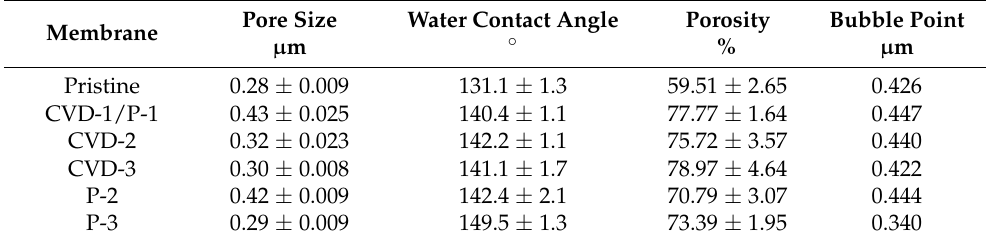
Table 2. The membrane characterization of different CVD and plasma treatment times for modi- fied